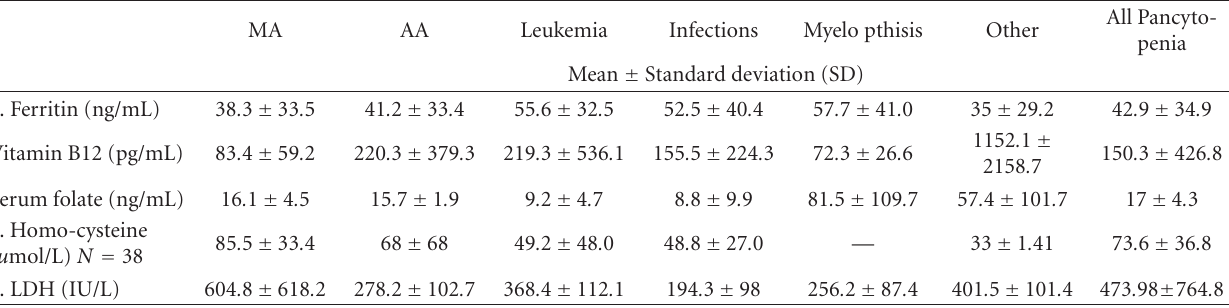
Table 3: Vitamin assays in